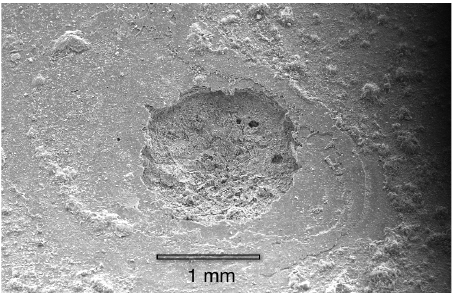
Figure 8. A corrosion pit, after both the malachite mound and cuprite membrane were